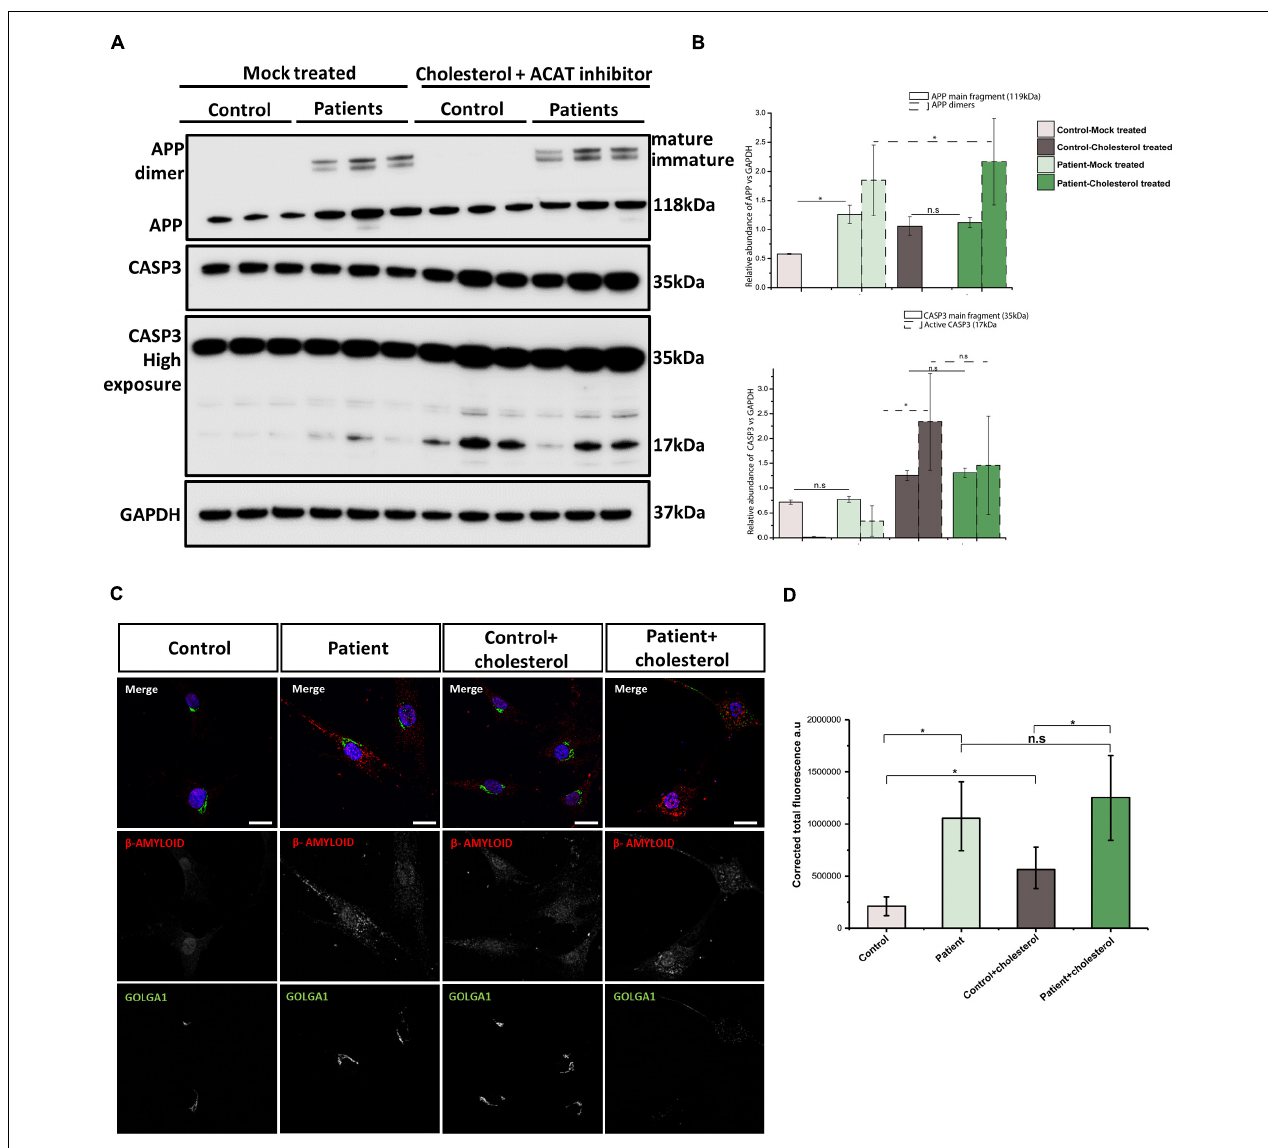
FIGURE 5 | Analysis of amyloid accumulation in DNAJC3 mut cells. (A) Immunoblotting of APP reveals increased levels of this protein monomer in DNAJC3 mut cells, while cholesterol treatment leads to a further increase only in control cells. (B) Densitometry analysis of immunoblotting from panel (A) . Graphs show ± SD of triplicate samples, and all data were normalized to GAPDH. The mature and immature APP dimers on immunoblotting are present only in the DNAJC3 mut cells and cholesterol treatment increases the amount of these proteins, which are further cleaved to form the β -amyloid (A β ) fragment. Cholesterol treatment induced an activation of caspase-3 protein (corresponding to the 17-kDa fragment), indicating an increase in apoptosis Student’s t -test, * p < 0.05. (C) Representative A β and GOLOGA1 staining in control and DNAJC3 mut cells in the presence and absence of cholesterol. Bar plots represent the corrected total florescence measured for the A β in three DNAJC3 mut and three controls in mock and cholesterol-treated cells. Immunofluorescence analysis shows that DNAJC3 mut fibroblasts present an increase in A β while the cholesterol treatment exacerbates the accumulation of the toxic fragment in patient cells. The cholesterol treatment leads to a slight increase in the A β in control cells as well; * t -test <